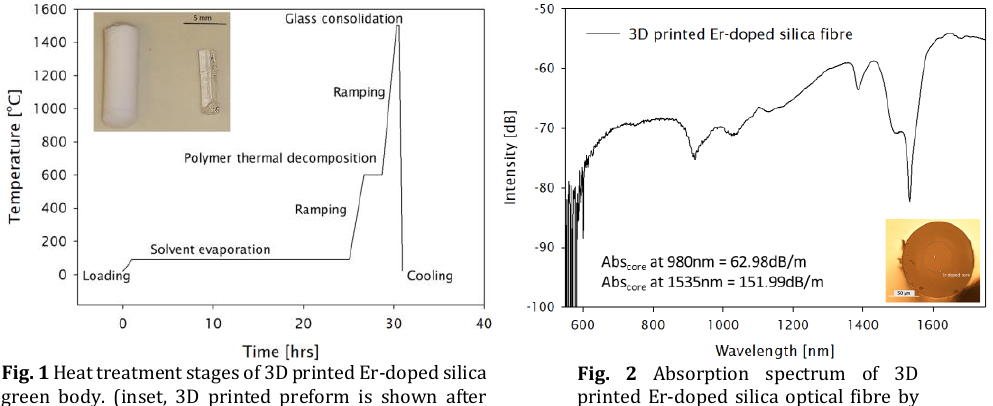
Fig. 2 Absorption spectrum of 3D printed Er-doped silica optical fibre by